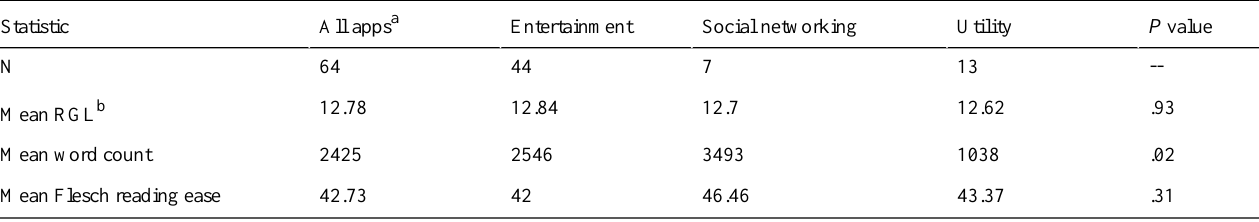
Table 3. Mean readability statistics. Entertainment versus social networking versus utility: comparison of mean reading grade level (RGL), mean word count, and mean reading ease between entertainment, social networking, and utility apps. The P values for the analysis of variance (ANOVA) tests show that there is no significant difference in the mean RGL and reading ease between the app categories, but there is a significant difference in mean word count.